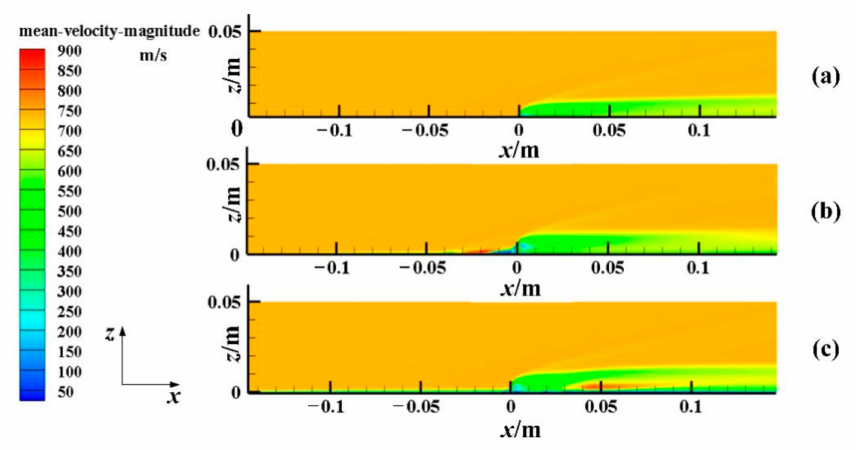
Figure 10. Time-average velocity flow field contour diagrams for ( a ) Case a, ( b ) Case b, and ( c ) Case c at y = 0